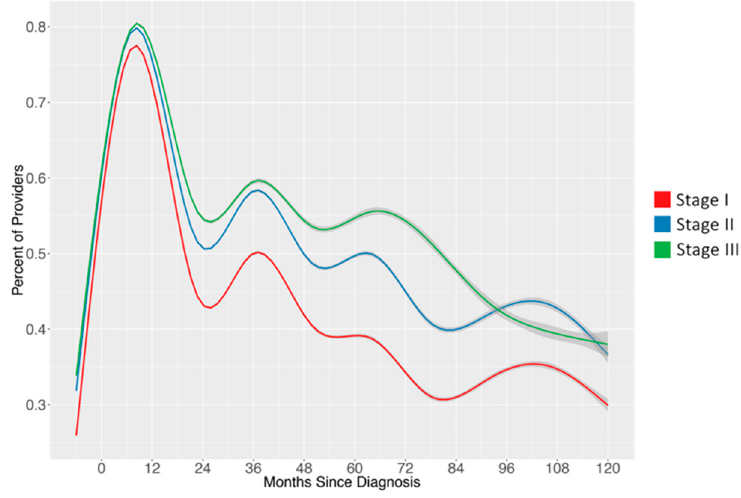
Figure 2. Percentage of appointments with oncology ‐ related providers by month relative to diagnosis.